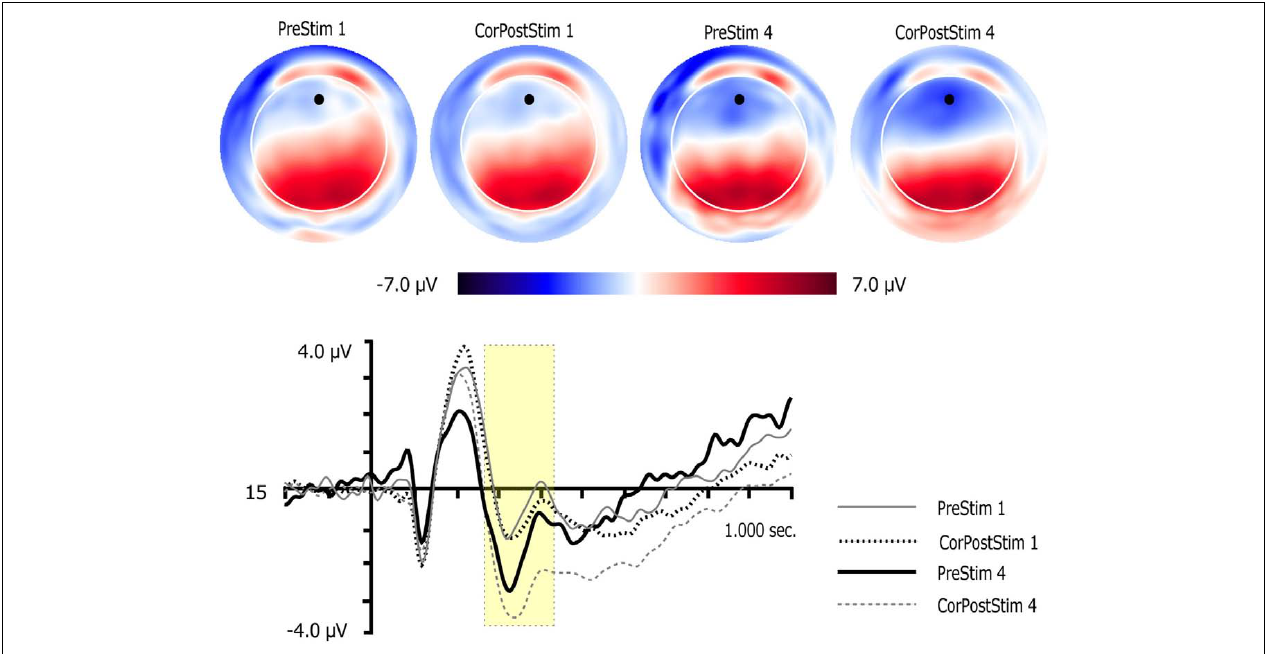
with nose at the front. Black circles on 2D maps represent channel locations of the waveform plots.Yellow boxes in waveform plots mark the time window used to quantify the MFN.Vertical lines in waveform plots mark onset of targets.